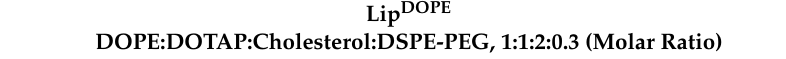
Figure 1. ( a ) Identification of potential microRNAs in the latent state of HSV-1 infection against HSV-1 target protein, ICP0, by means of NGS-sequencing of differentiated, latently infected human neural progenitor cell line (ReNcell VM). A set of viral miRNAs highly expressed in differentiated ReNcell VM cells has been identified, and the miRNAs sequences, miR-H2 and miR-H6, have been further analyzed for antiviral activity; ( b ) the antiviral effect of the respective siRNAs in the plaque reduction assay (a confluent layer of HaCaT cells): free si-H2 and siH6 (upper panel) in comparison to siRNAs transfected by lipofectamine (lower panel). The formed syncytia, shown in brownish red, was visualized following immunohistochemistry staining of the cells (anti-HSV1 antibody). Brownish red depicts the envelope-protein of the virus, indicating proliferative infection (scale bar = 200 µm). Table 1. The physicochemical properties of Lip DOPE